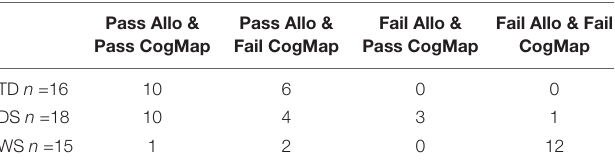
TABLE 11 | Number of participants who passed or failed the open-field allocentric spatial memory task with one location and with vision (Bostelmann et al., 2017, 2018) and the cognitive mapping task with four objects in the absence of vision (current study). Pass Allo & Pass Allo & Pass CogMap Fail